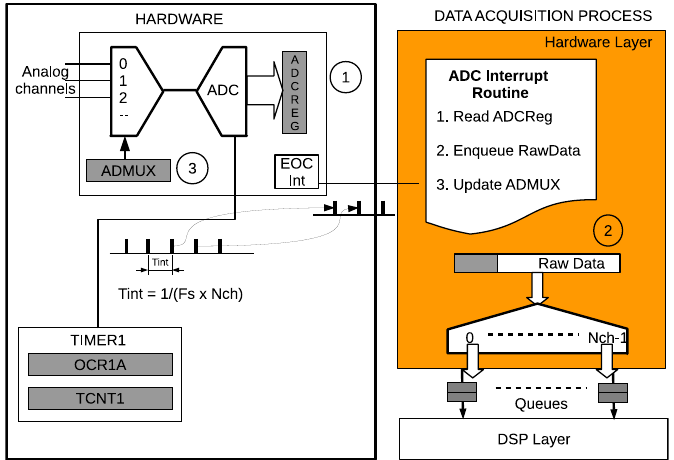
Figure 3. Timer1 is configured to trigger the Analog to Digital Converter, ADC, at a frequency rate of F s / N ch . The End-of-Conversion (EOC) interrupt (1) makes the ADC interrupt routine to read the data, sends it (2) to the Digital Signal Processing or DSP layer through the appropriate queue and (3) updates the ADC multiplexer, ADMUX, to select the next channel for